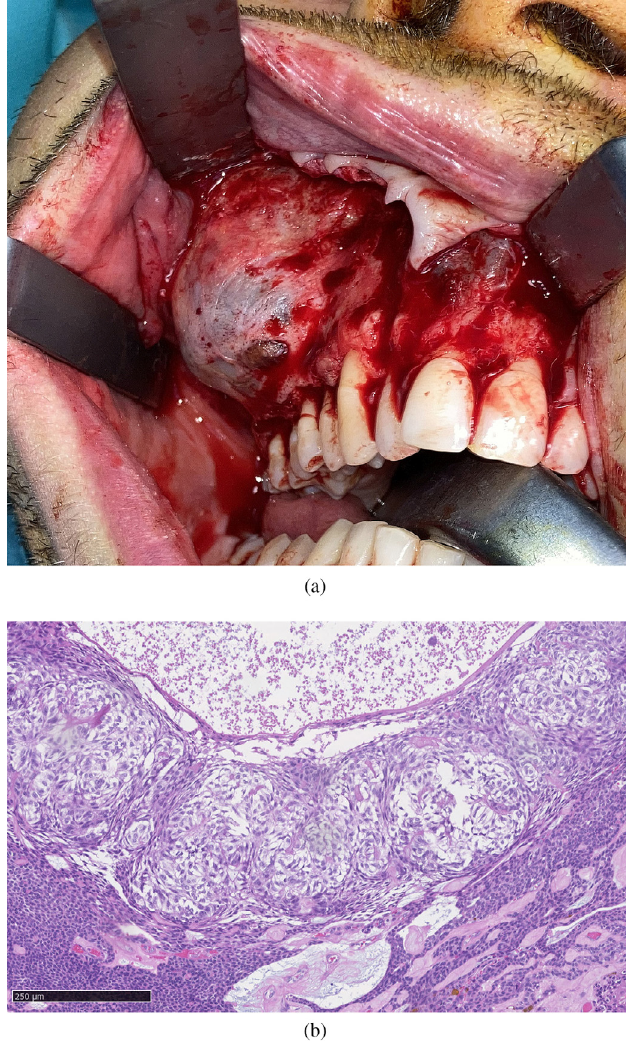
Fig. 1. The maxillofacial-CT showed a wide well-de fi ned osteolytic lesion of the right maxillary; coronal (a) and 3D (b) views.